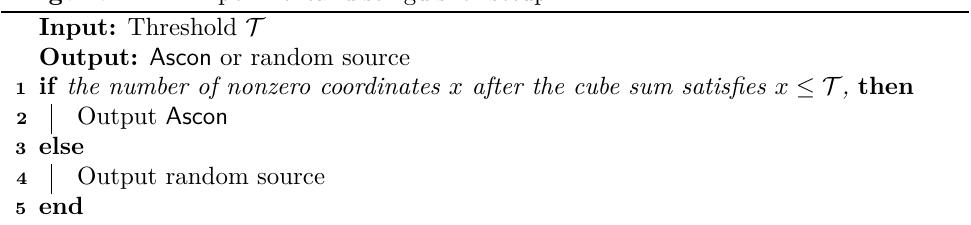
Algorithm 1: Experimental distinguisher setup